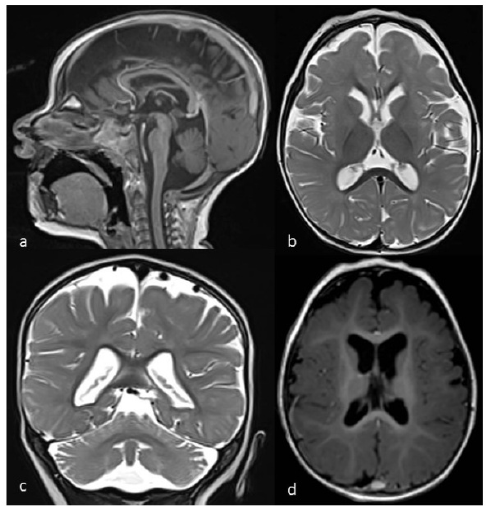
Figure 2. Brain MRI (T1-weighted in ( a , d ); T2-weighted in ( b , c )) of the patient performed at age 14 months showing thin corpus callosum and hypoplasia of pons ( a ) and cerebellar vermis ( a , c ), simplified gyral pattern with reduction in frontal gyri and enlargement of sub-arachnoids spaces ( b , d ), mild reduction in the total amount of white matter ( b , d ) and enlargement of cerebellar interfolial spaces ( c ).